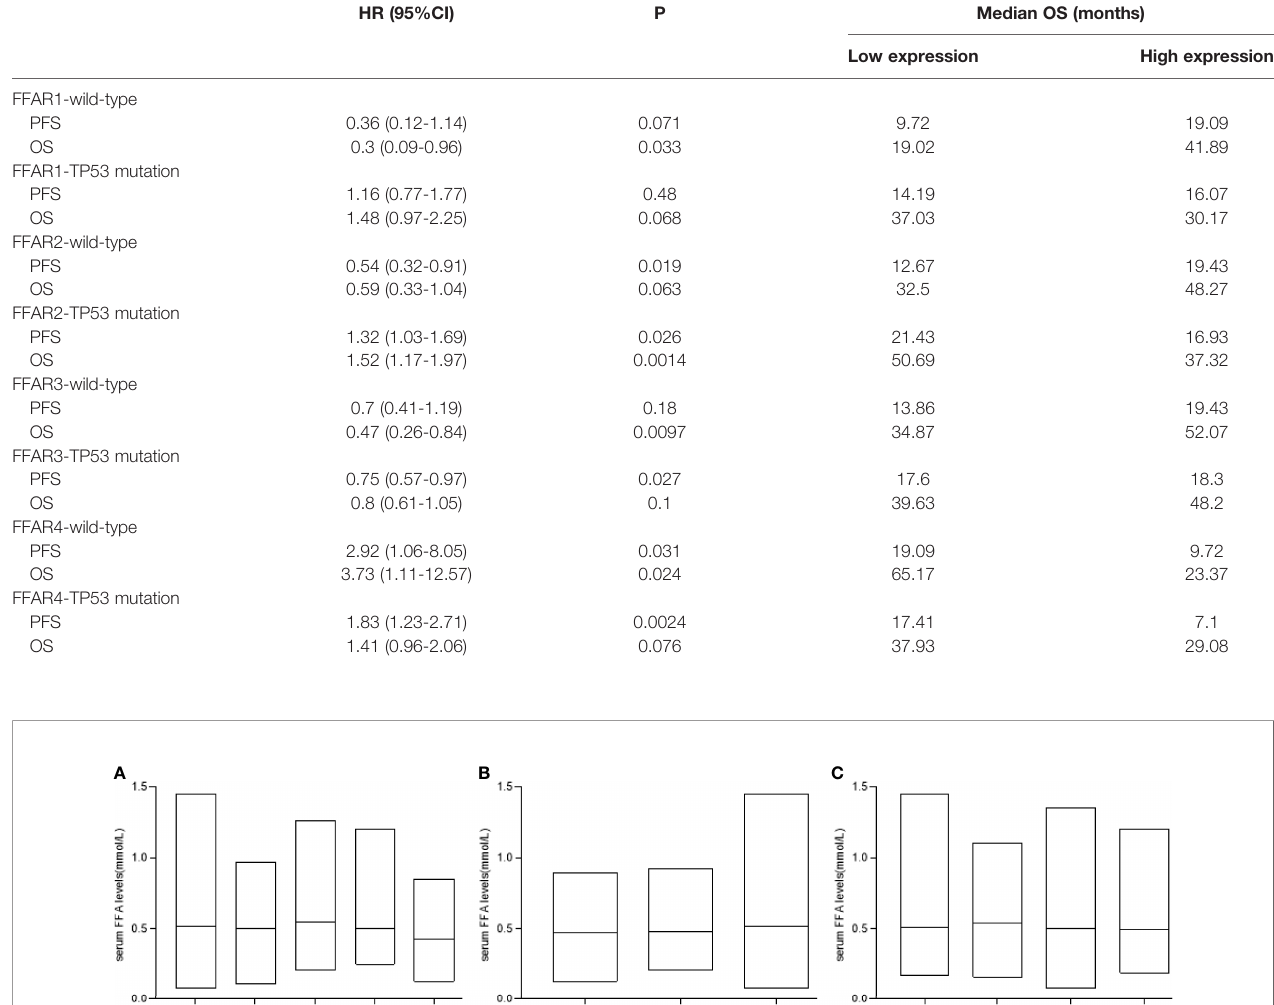
TABLE 2 | Survival analyses of FFAR1 and FFAR4 in ovarian cancer (Kaplan – Meier plotter). HR (95%CI) P Median OS (months) Low